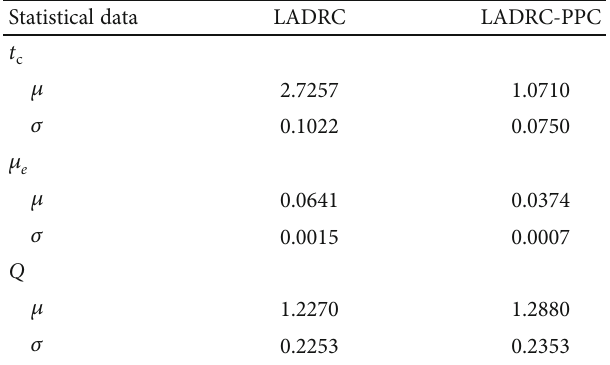
Table 3: The statistical results of the Monte Carlo